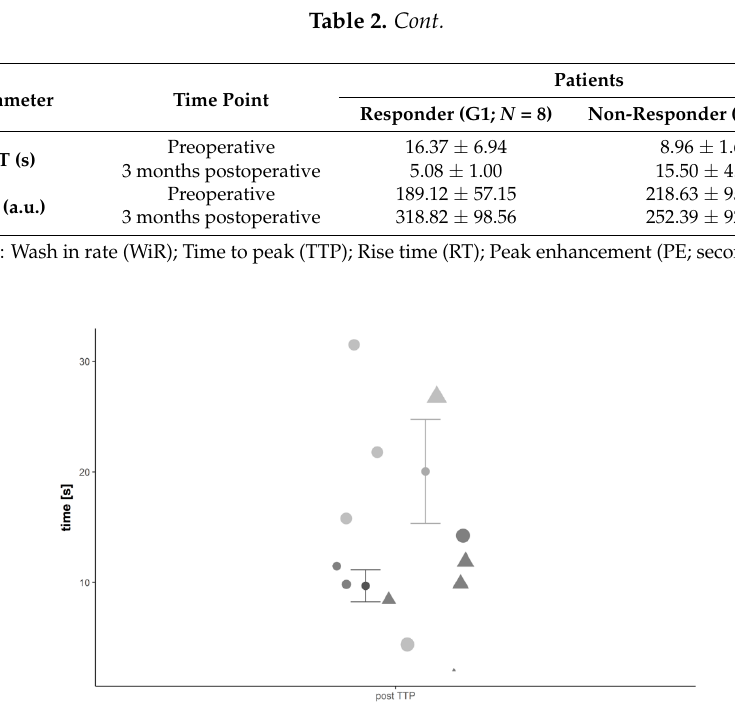
Figure 3. Visualization of results from CEUS analysis. In particular, results from the analysis of the parameter time to peak (TTP) 12 weeks subsequent to the second step are shown and compared between groups. Dark points with whiskers display mean time in Responders, grey points with whiskers indicate mean time in Non-Responders (whiskers are the standard error of the mean (SEM). Results are further stratified to age and sex and values for each participating patient are given. Here, triangle indicates male sex and dots female sex, size of symbol increases with age of patient.